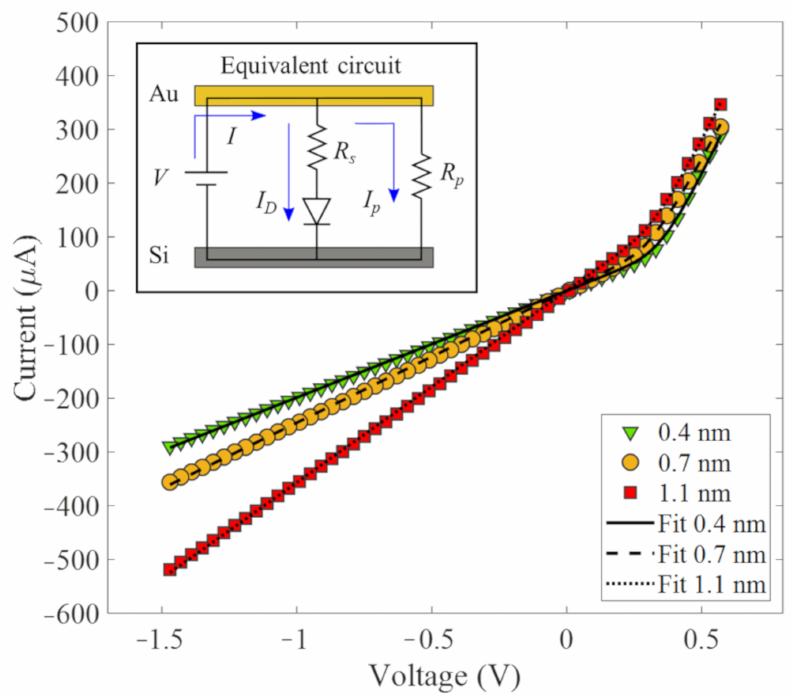
Figure 6. Room temperature dark I–V curves of samples with wall thickness of 0.4 nm, 0.7 nm, and 1.1 nm. Equivalent circuit